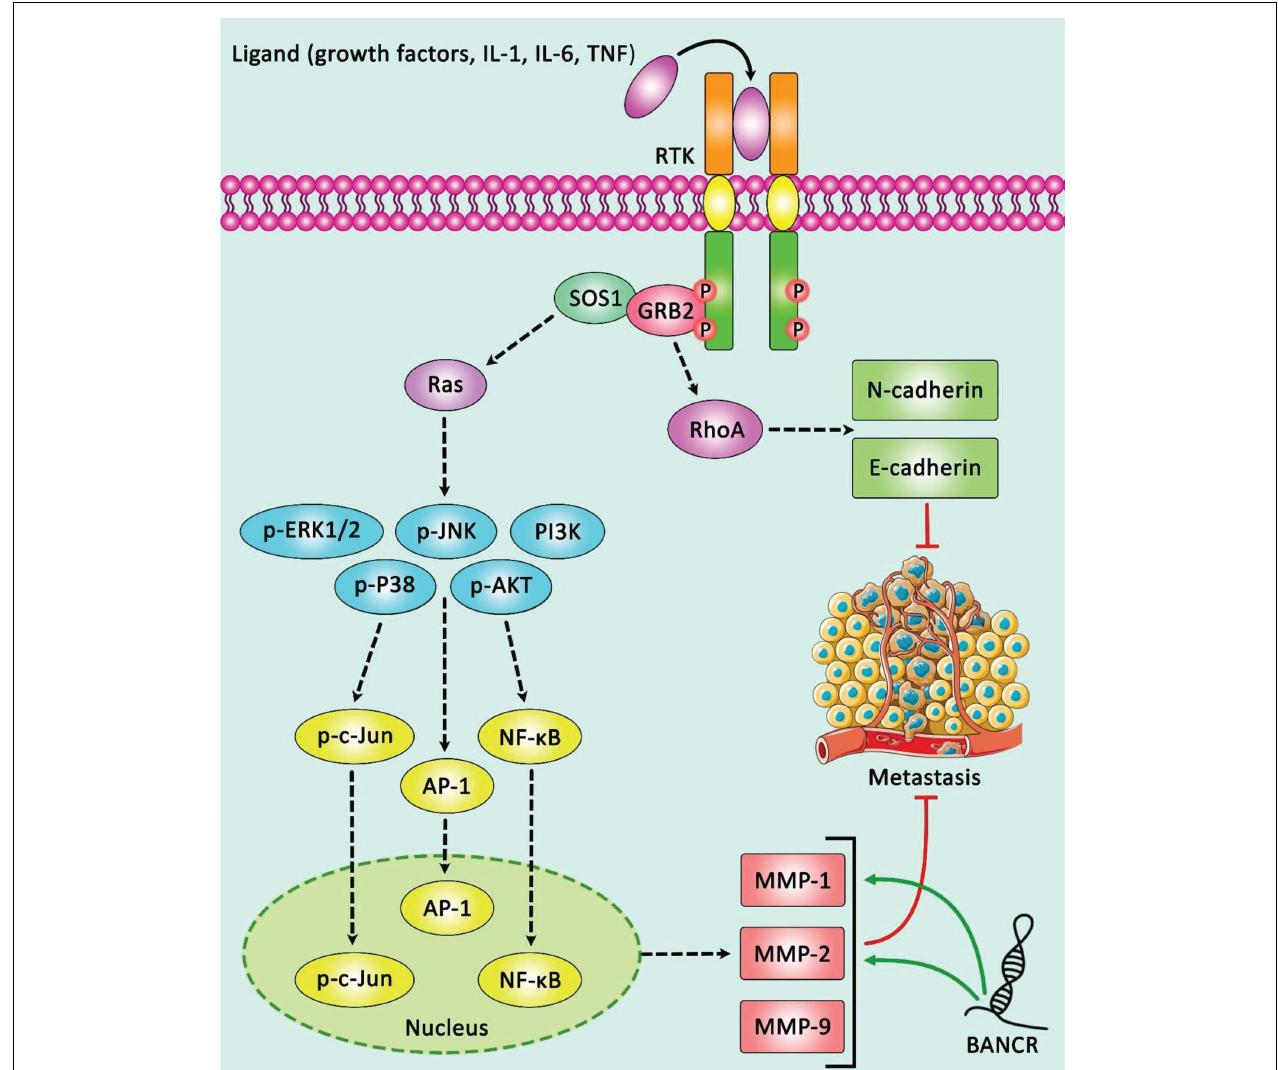
FIGURE 4 | A schematic diagram of oncogenic role of lncRNA BANCR in modulating the expression of MMP2 and MMP1 via ERK/MAPK cascade in endometrial cancer. LncRNA BANCR could up-regulate in type 1 endometrial cancer tissues, and play an effective role in the progression of this type of tumor. This lncRNA via activating ERK/MAPK signaling pathway could promote the expression levels of MMP2 and MMP1, and thereby suppressing cell proliferation, migration, and invasion of EC cells (Wang D. et al., 2016). Green arrows indicate the up-regulation of target genes modulated via lncRNA